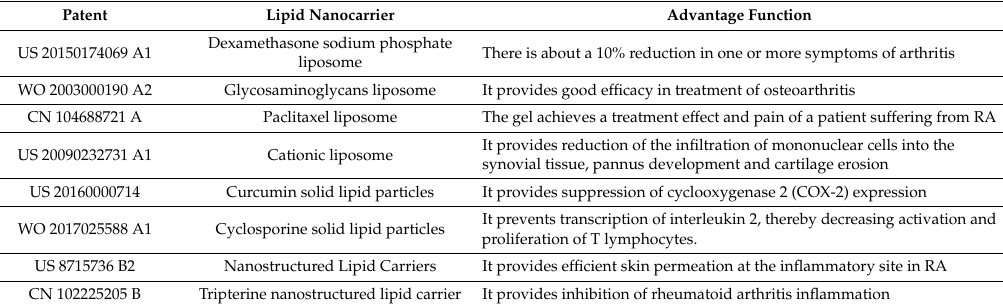
Table 4. Clinical application of nanotherapeutic agents in arthritic